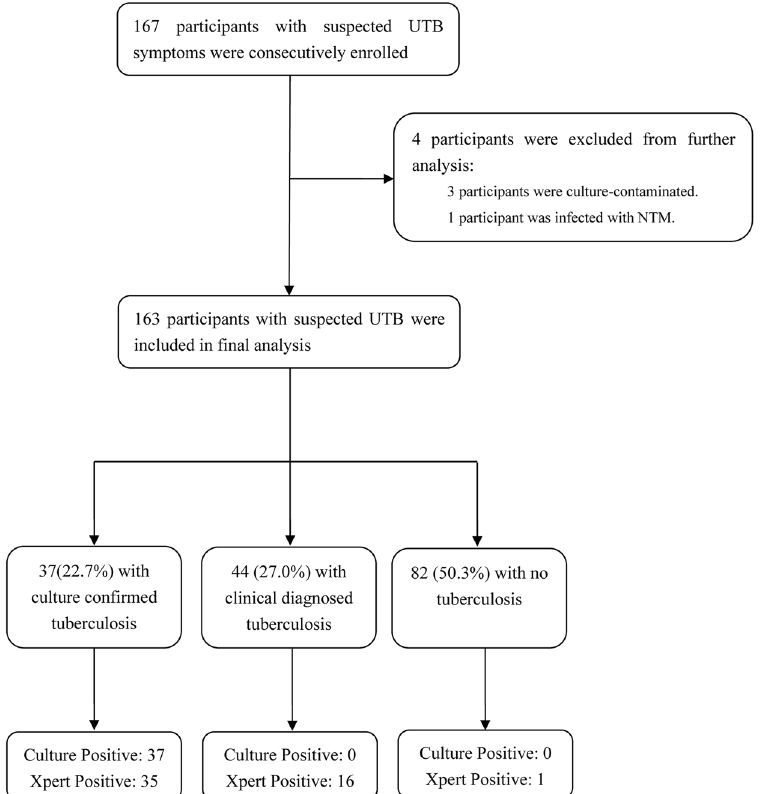
Figure 1. Enrollment of suspected urinary tuberculosis patients.